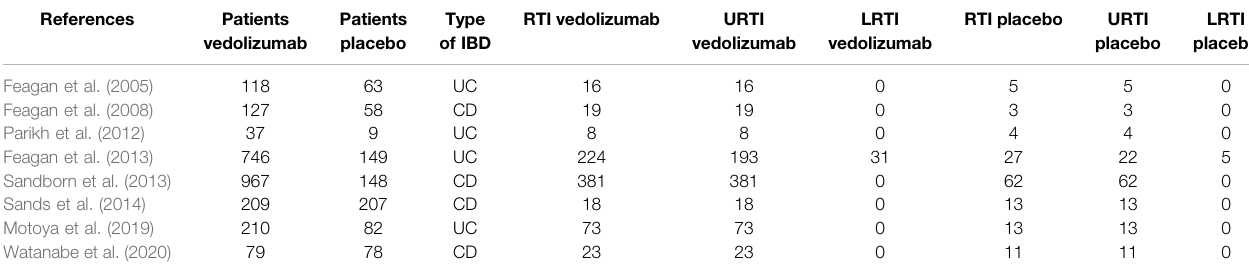
TABLE 1 | Number of patients enrolled in the indicated randomized, placebo-controlled clinical studies and number of respiratory tract infections in patients treated with either vedolizumab or